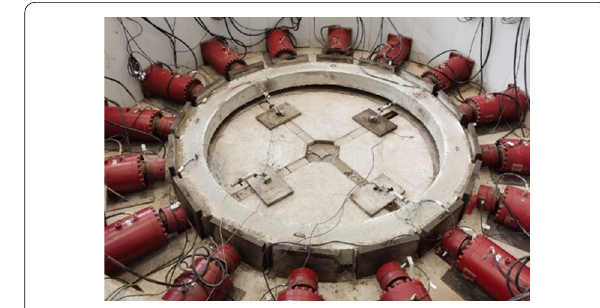
Fig. 11 Wellbore model test system.